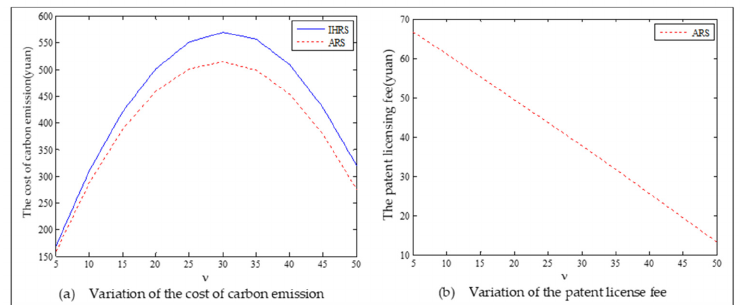
Figure 6. Changes of the costs of carbon emission and the patent licensing fee in Case 1 of Section 6.1.